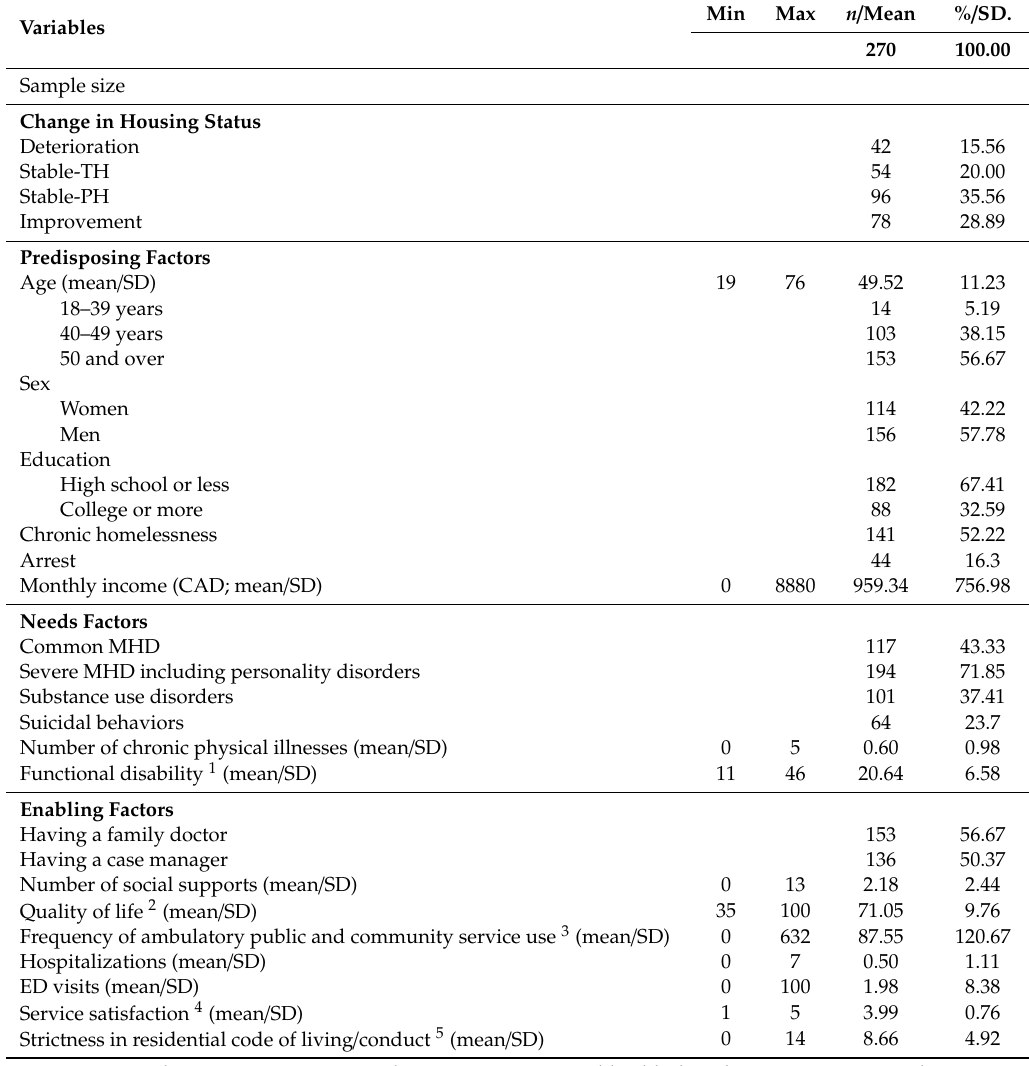
Table 1. Participant characteristics at T1 (12-month follow-up; n =